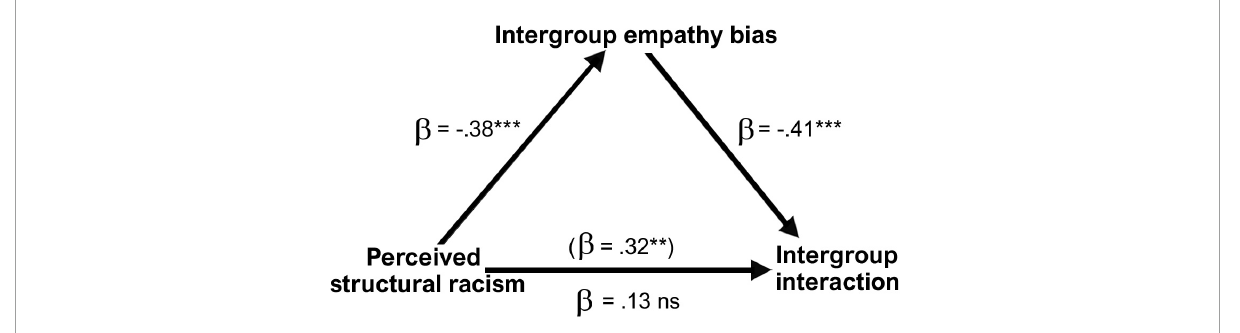
FIGURE4 Intergroup empathy bias for situations of structural racism (scenario 1) fully mediated the effect of perceptions of anti-Black structural racism today on willingness to engage in intergroup interaction about historical oppression ( R 2 = 0.23, p < 0.001). Data presented are standardized β coefficients. ** p < 0.01, *** p <